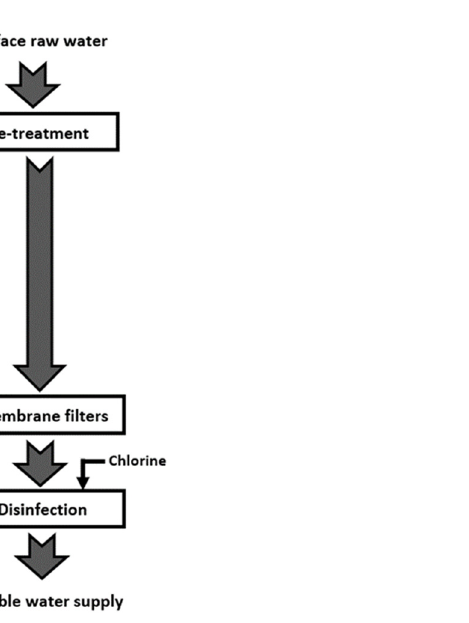
Figure 1. Block diagram comparison between conventional and membrane-based water treatment systems.